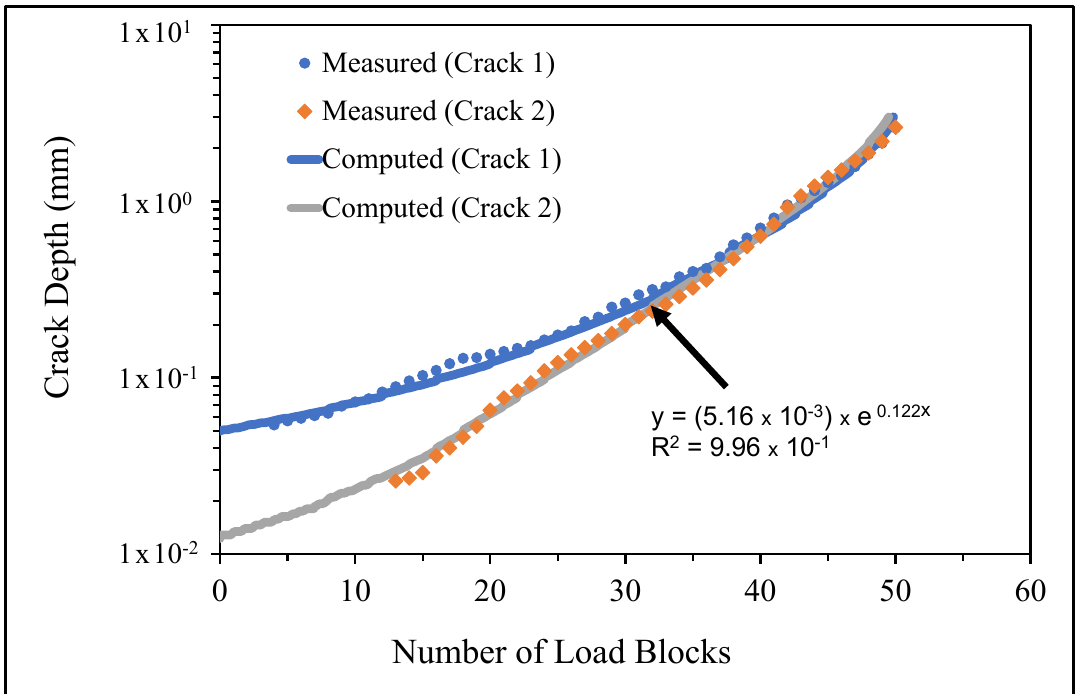
Figure 10. Measured and computed crack growth histories for specimen 3.